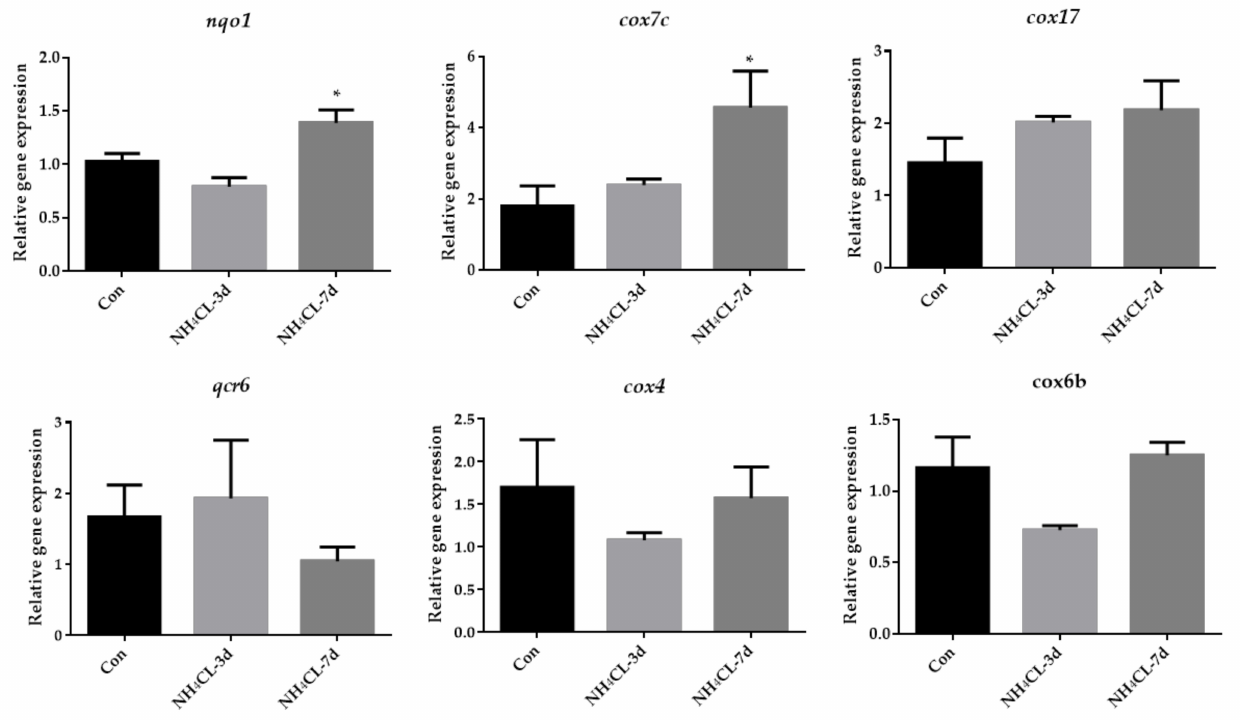
Figure 8. The expression of genes related to oxidative phosphorylation ( nqo1 , cox7c , cox17 , qcr6 , cox4 , cox6b ) in largemouth bass liver after ammonia exposure for 3 days and 7 days was affected. All data were analyzed with Student’s t -test and data were mean ± SEM ( n = 6). * p <